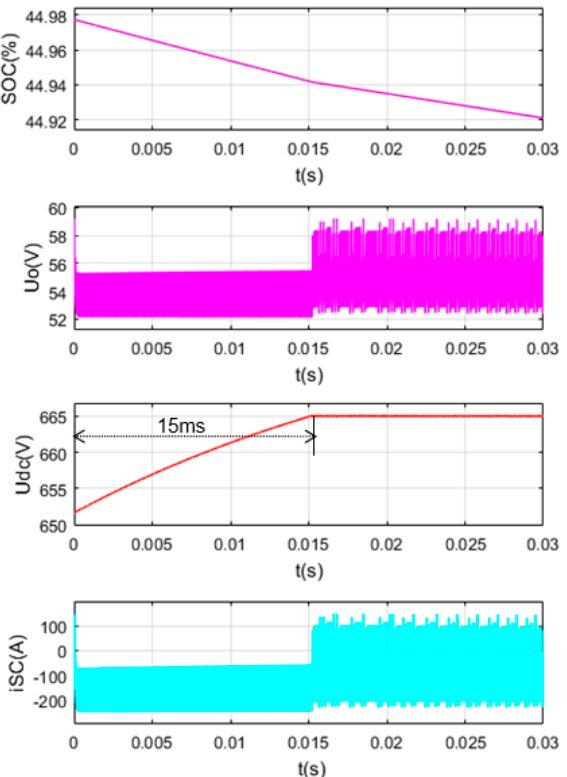
Figure 12. Simulation waveform diagram of the MPC for the DAB-SC system when the initial voltage, U dc , is 651.7 V and the initial voltage, U o , is 56.58 V.